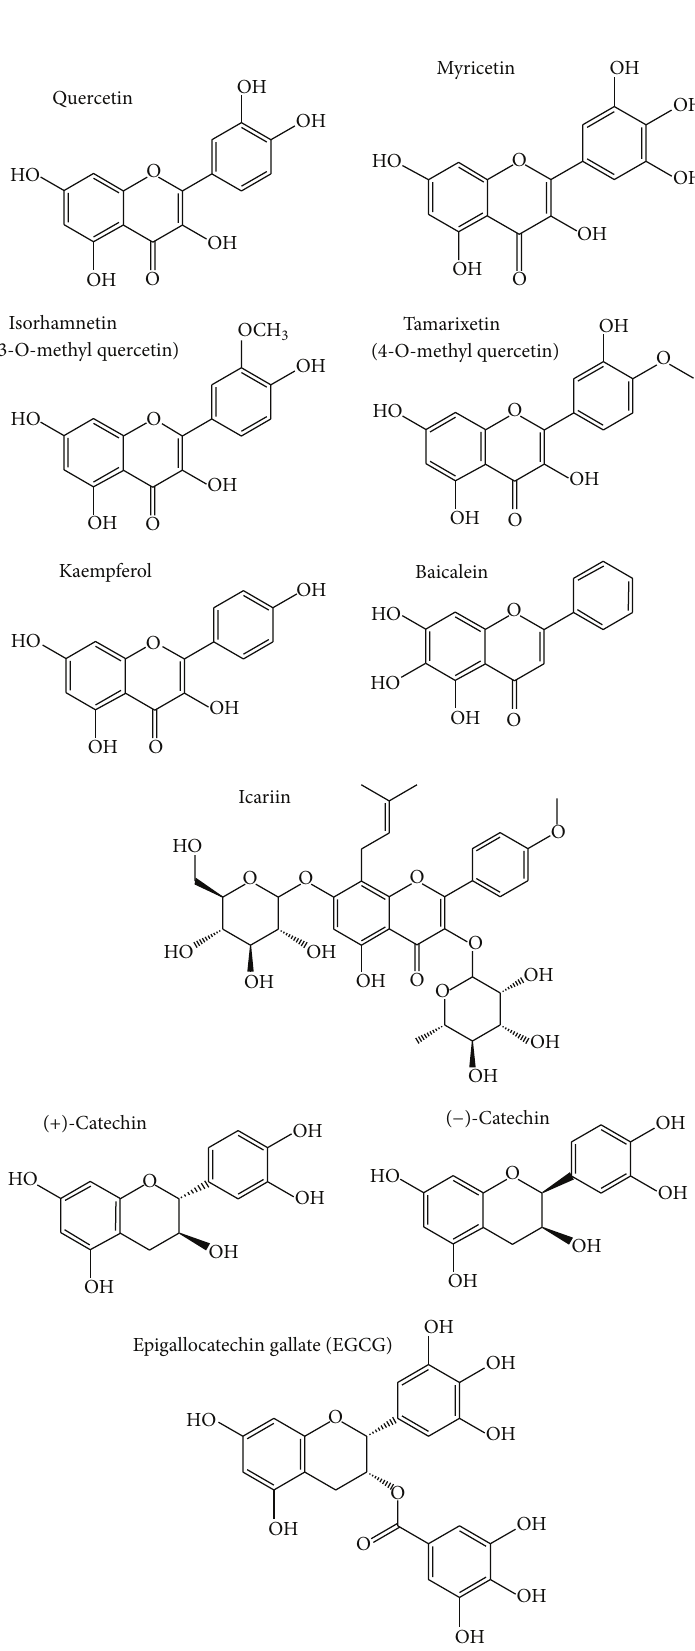
Figure 1: Major flavonoids studied in C. elegans